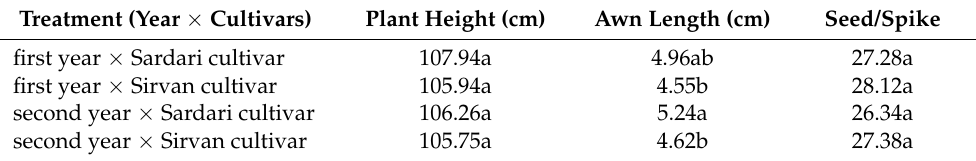
Table 2. Mean comparisons of dual interaction of year and irrigation on peduncle length in wheat. Treatment (Year × Irrigation) Peduncle Length (cm) Grain Yield (kg/ha) Dry farming × first year 39.14a 3687.66a Irrigation once × first year 39.78b 4625.16a Irrigation twice × first year 40.36ab 5003.75b Dry farming × second year 37.04ab 3508.59b Irrigation once × the second year 37.28b 4436.41a Irrigation twice × second year 39.98ab 4856.88a